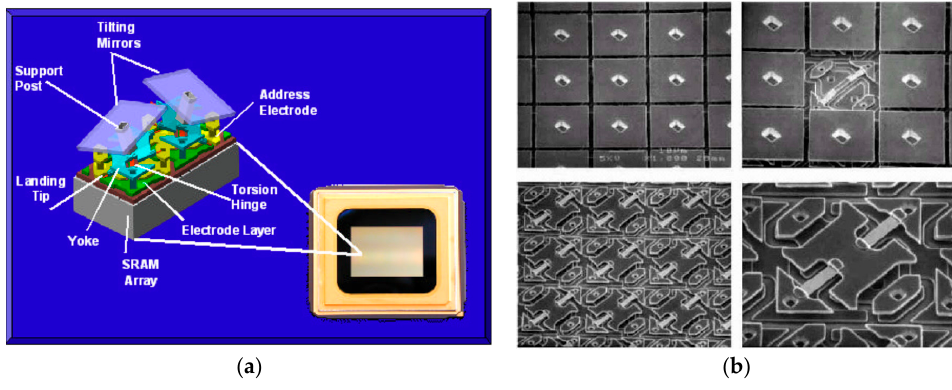
Figure 4. Schematic of two digital mirror device (DMD) mirror-pixels in a digital light processing (DLP) cinema chip ( a ) and scanning electron microscope (SEM) image of an array of DMD micromirrors ( b ). From www.dlp.com.